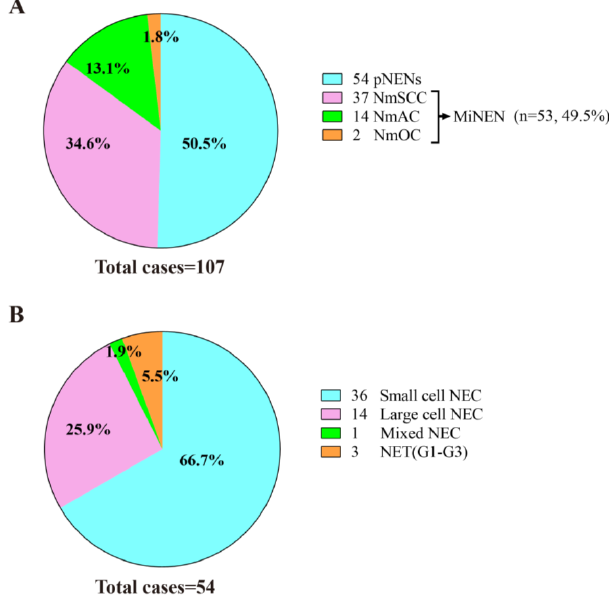
Figure 2. Pie chart of the number of E-NENs patients. ( A ) The constituent proportion of all patients with E-NENs. ( B ) The composition ratio of pNENs patients. Abbreviations: pNENs, pure neuroendocrine neoplasms; NmSCC, neuroendocrine neoplasms mixed with squamous cell carcinoma; NmAC, neuroendocrine neoplasms mixed with adenocarcinoma; NmOC, neuroendocrine neoplasms mixed with other carcinomas; NEC, neuroendocrine carcinoma; NET, neuroendocrine tumor.